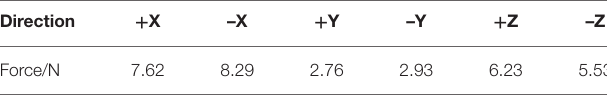
TABLE 1 | Maximum forces measured in each axis during force exertion